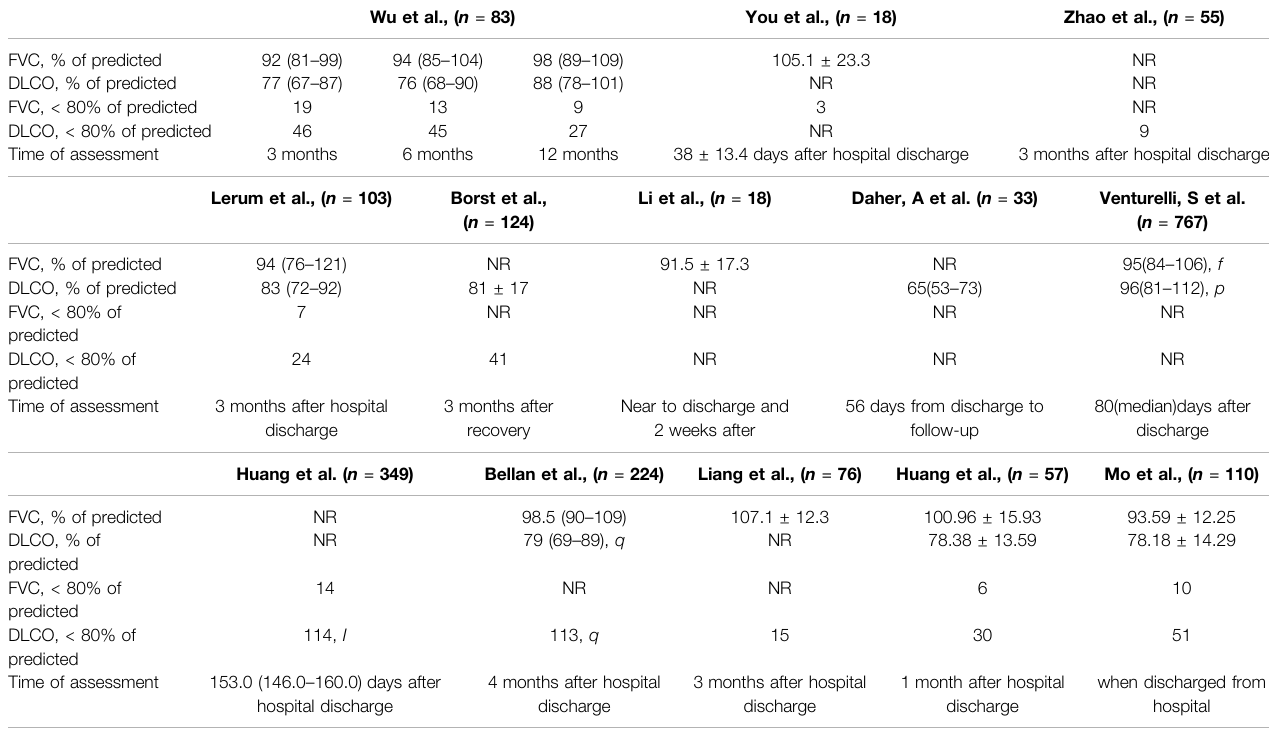
TABLE 2 | Summary of studies included pulmonary function test.